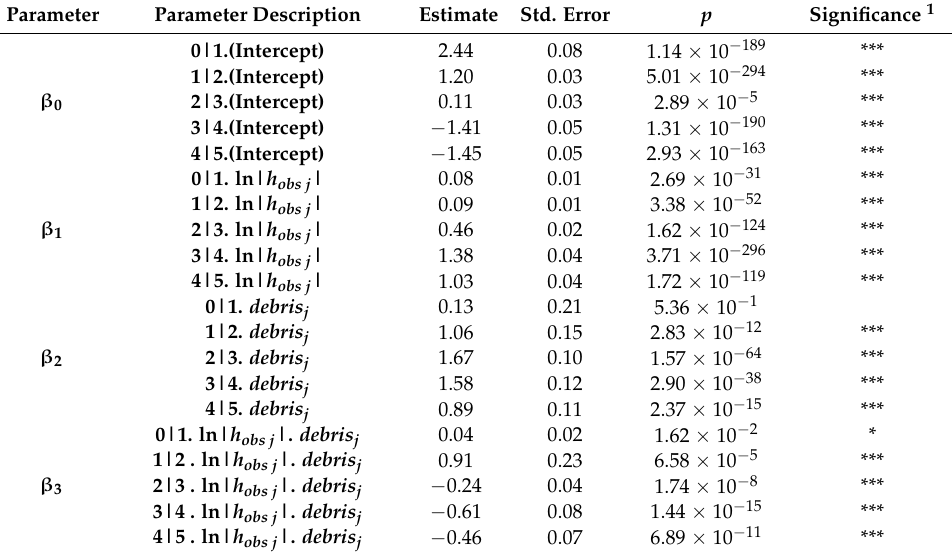
Table 3. Regression parameters of model (4).